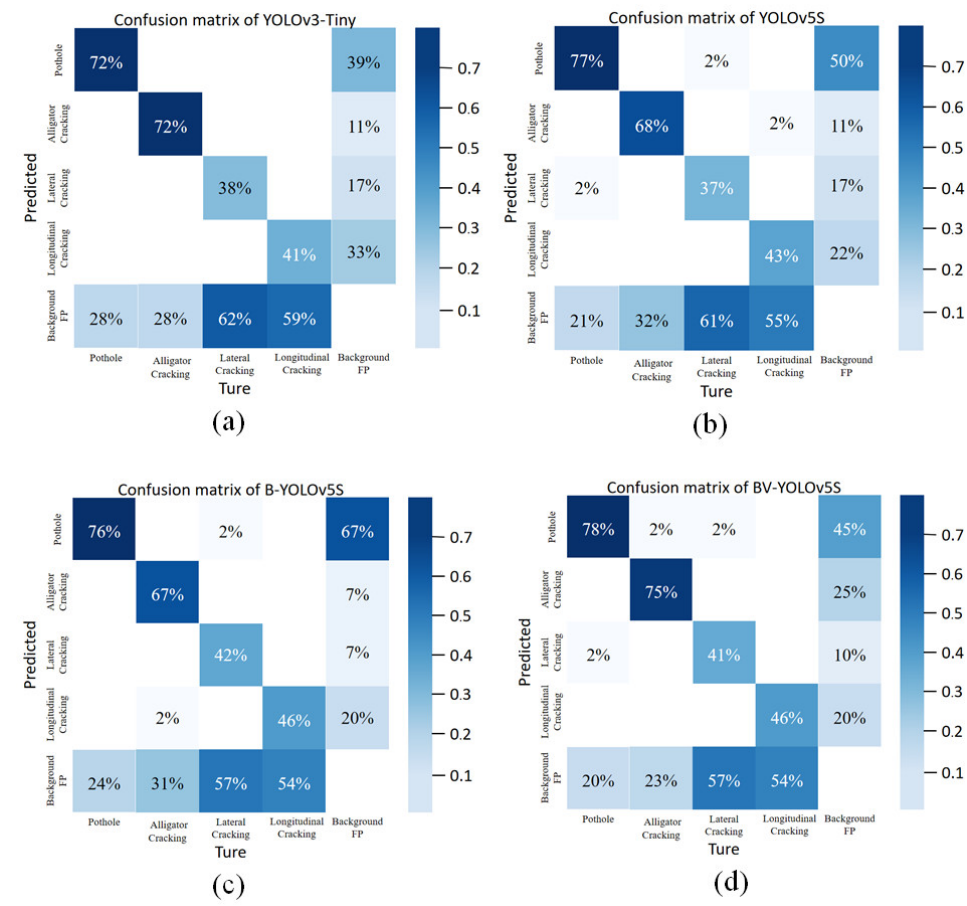
Figure 8. The confusion matrix of the comparison of the different defect detection algorithms. ( a ) YOLOv3-Tiny; ( b ) YOLOv5S; ( c ) B-YOLOv5S; ( d ) BV-YOLOv5S.